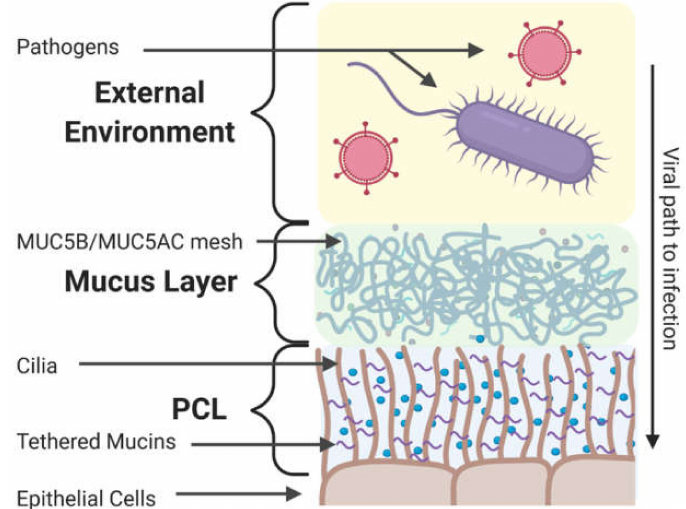
Figure 2. Cross-section of the respiratory tract mucosal barrier. Epithelial cells of the proximal airways are protected by a dense PCL and overlying mucus gel layer. Pathogens can be slowed or trapped in this restrictive gel while the coordinated beating of underlying ciliated epithelial cells propels this gel away from the more vulnerable distal airways towards gastrointestinal clearance. Created with